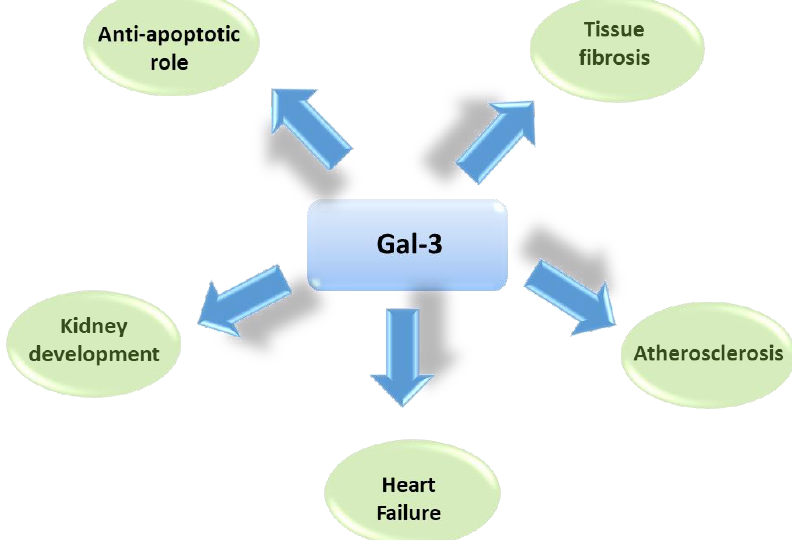
Figure 2. Schematic representation of main roles of Gal-3 in several physiologic and pathogenetic Figure 2. mechanisms.